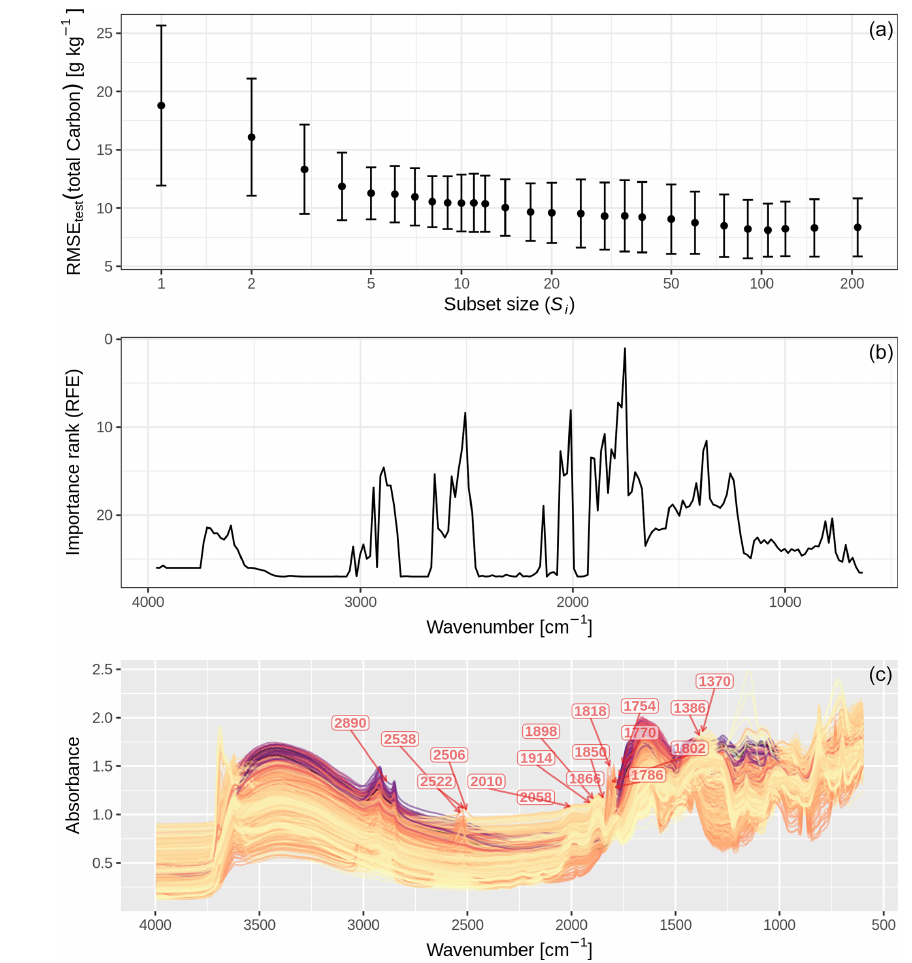
Figure 4. (a) Root mean square error (RMSE) of mid-IR estimates of total C that CUBIST produced at the respective subsets of spectral variables. The performance profile was obtained with a recursive feature elimination (RFE) procedure. The error bars represent the standard deviations of the test RMSE derived with nested cross-validation ( n = 50). (b) Average importance ranks across the spectrum. Lower rank values indicate higher importance for the estimation of total C. Ranks were determined with RFE. (c) Mid-IR absorbance spectra of the Swiss soil spectral library ( n = 4295; with corresponding total carbon (C) measurements determined by dry combustion). The unprocessed absorbance spectra are annotated with the 17 most influential spectral variables (wavenumbers) in the CUBIST model (average importance rank < 15); these had the highest mean importance ranking determined by the recursive feature elimination